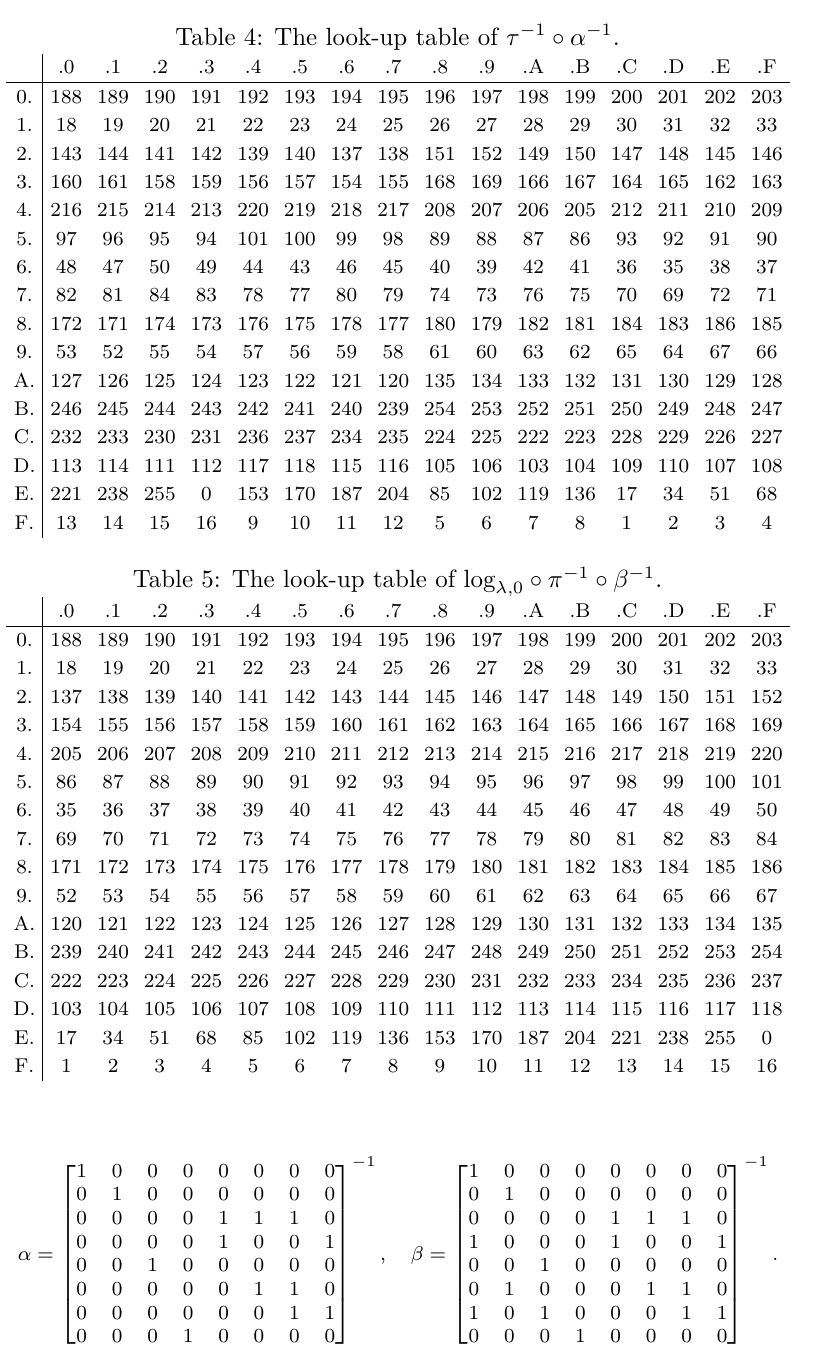
Table 4: The look-up table of 𝜏 − 1 ∘ 𝛼 − 1 .